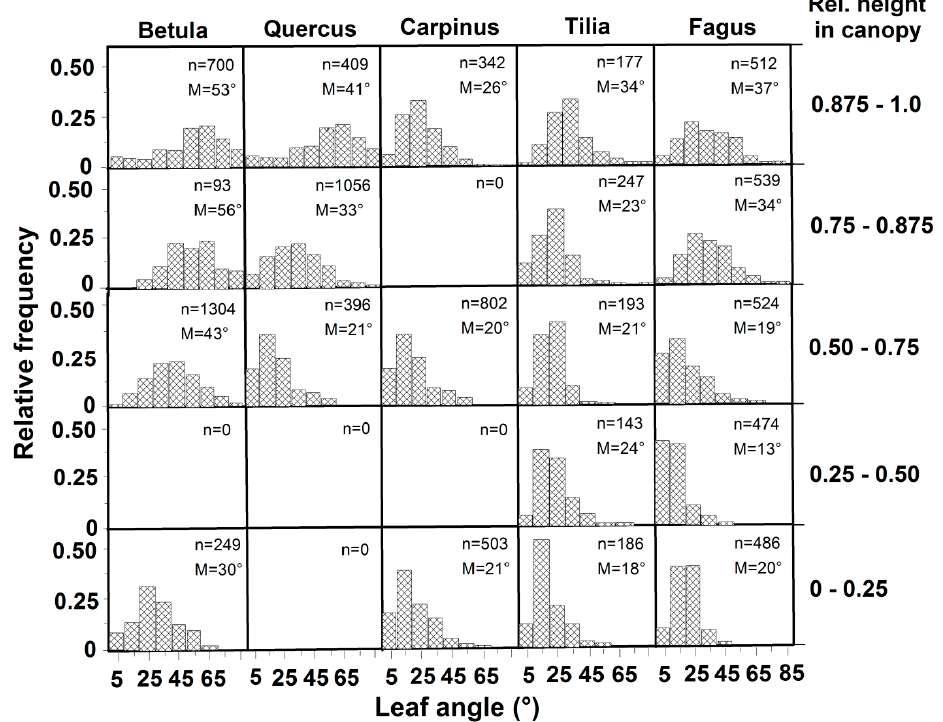
Figure 4. Frequency distribution of leaf angles (degrees from horizontal) in five height levels in the canopy of the five species. Width of angle classes: 10°. Given are the number of measured leaves and the arithmetic mean (M). n = 0 indicates a lack of leaves at this height level or the absence of suitable twigs that could be accessed for measurement.